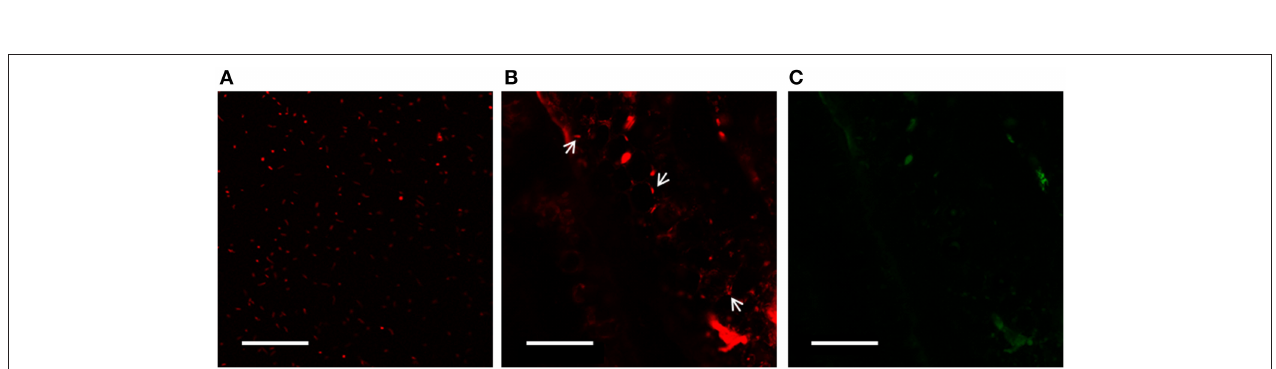
FIGURE 8 | CLSM analysis. Images of mCherry-tagged Salinicola peritrichatus SMJ30 strains (A) and colonized Spartina maritima stems after 25 days of growth and inoculation with the endophytic consortium (B, C) . White arrows in (B) show bacteria colonizing the stem. Images were taken with different laser conditions to discriminate tissue fluorescence: (B) excitation 568–585nm—long pass emission for red fluorescence; (C) excitation 488nm—emission 522/35nm for green fluorescence. Images were processed with ZEN Lite 2012 software. Scales bar represent 50 µ m.